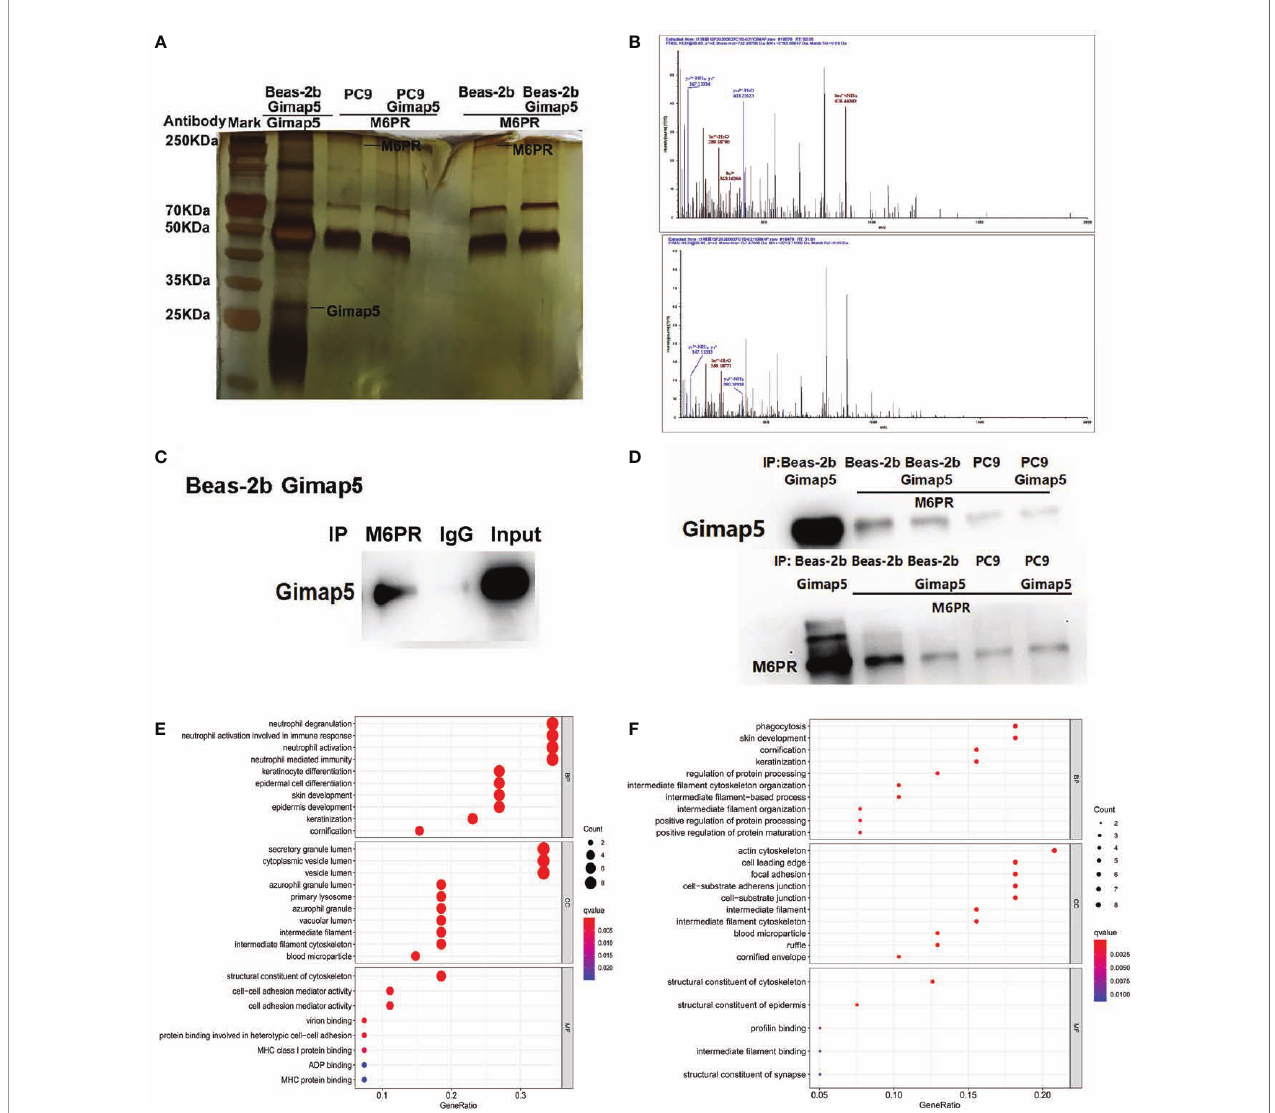
FIGURE 5 | The interacted proteins of Gimap5 were screened using combined Co-IP and LC-MS/MS. (A) Silver staining map of Co-IP assay using Gimap5 antibody after transfection of Beas-2b or PC9 cells with Gimap5 overexpressed vector. The fi rst lane represents marker; second lane is Co-IP using Beas-2b cells; the third lane is M6PR antibody to the Gimap5 IP products of the PC9 cells; the fourth lane is M6PR antibody to the Gimap5 IP products of the PC9-Gimap5 cells; the fi fth lane is M6PR antibody to Gimap5 IP product of Beas-2b cells; and the sixth lane is M6PR antibody to the Gimap5 IP product of Beas-2b-Gimap5 cells. (B) Secondary peptide spectra of M6PR were detected in the Co-IP products using Gimap5 antibody. (C) the total protein of Beas-2b was extracted, and the interacting proteins of M6RP were screened using Co-IP. Western blot using anti-Gimap5 antibody showed that M6RP interacted with Gimap5. (D) The expression levels of M6PR in Co-IP products of Gimap5 and the expression levels of Gimap5 in Co-IP products of M6PR antibody were detected using Western blot. (E) The GO analysis of mass spectrometry of Gimap5 interacted proteins. (F) The GO analysis of mass spectrometry of M6PR interacted